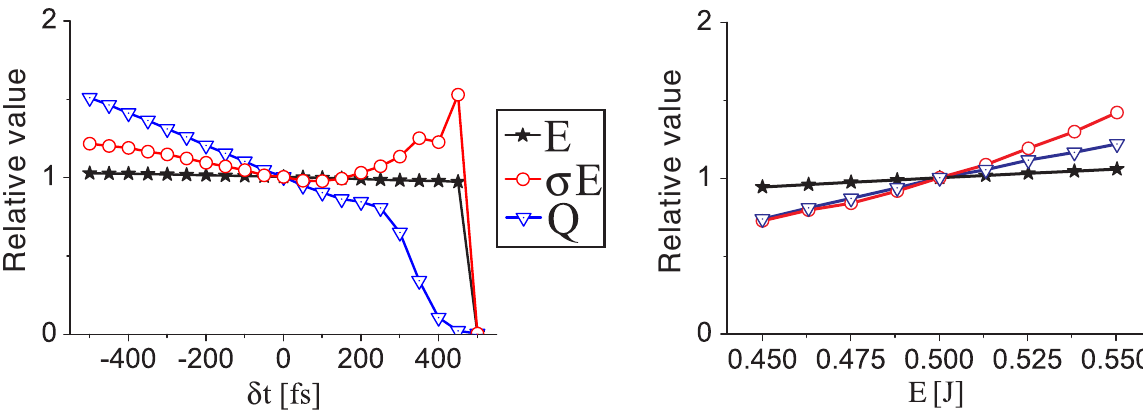
FIG. 5. (Color) Effect of (cid:1) 10% fluctuations in the laser energy on the final beam parameters [energy ( E ), energy spread ( (cid:5)E ), and trapped fraction ( Q )] for a laser of a 0 ¼ 0 : 32 with injection 300 fs behind the laser pulse.